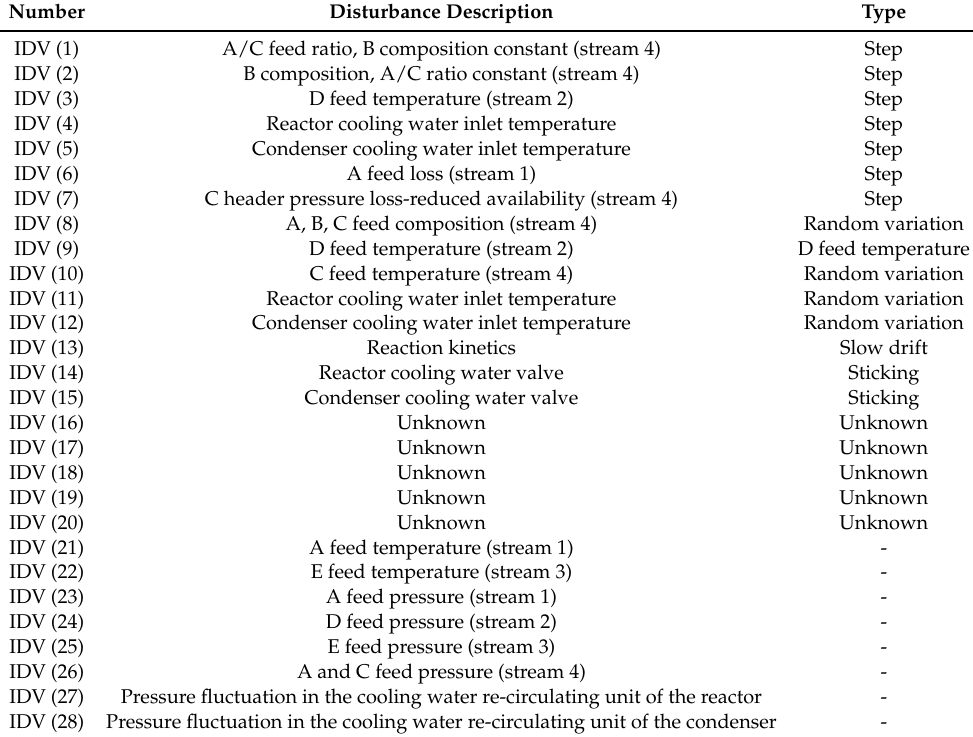
Table A2. The disturbances of TE process.